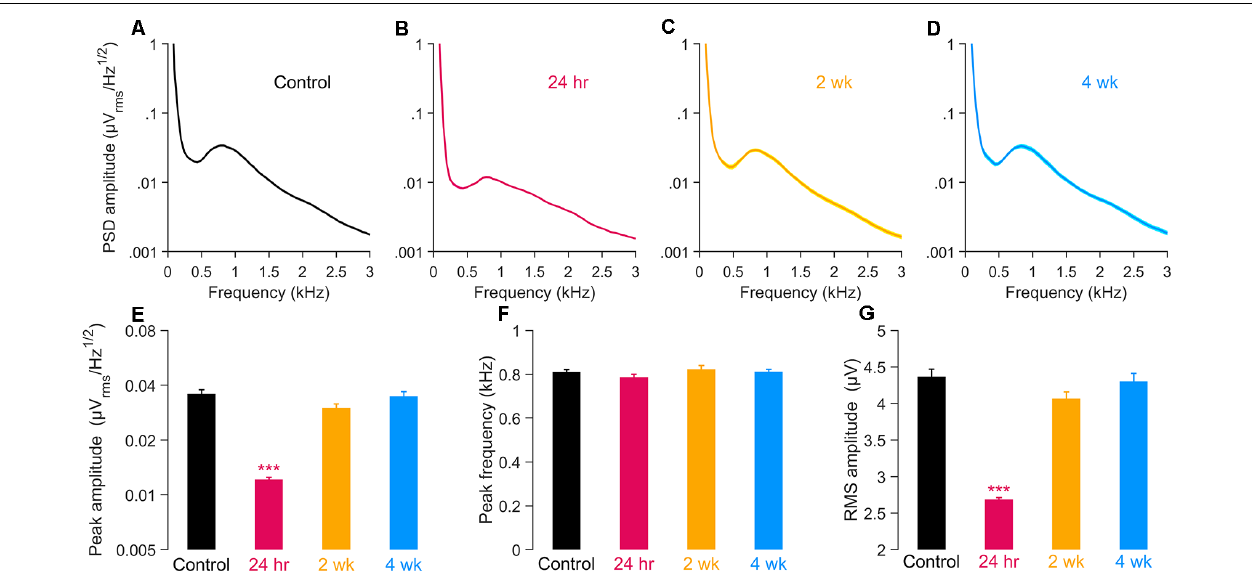
FIGURE 4 | Power spectral density (PSD) of spontaneous round window activity. (A–D) PSD in unexposed (A) and exposed gerbils 24 h (B) , 2 wk (C) , and 4 wk (D) after noise. (E,F) Amplitude (E) and frequency (F) of the spectral peak in the same groups. (G) Root-mean-square (RMS) amplitude of the PSD after applying 300–1200 Hz band-pass filter. In all panels, data are shown as means ± SEM, with group sizes as given in the Figure 1 caption. (E–G) Groups were compared using a one-way ANOVA and a post hoc test for multiple comparisons of groups; *** p <